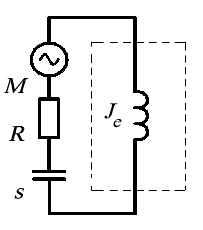
Fig 3. The generalized electrical analogue of mechanical system of the oscillating